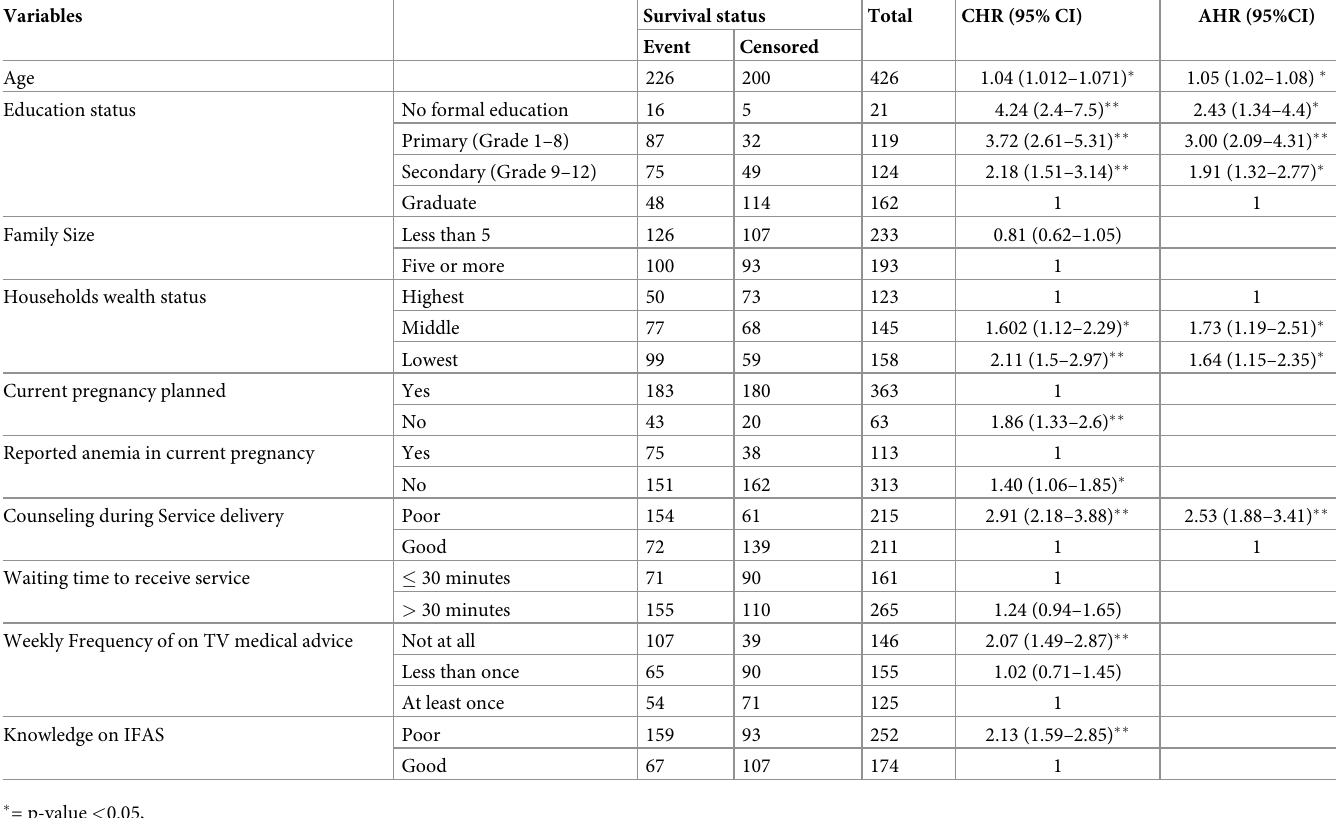
Table 3. Predictors of time to non-adherence of IFAS among pregnant women in Hosanna town, South Ethiopia, 2021 (n = 426).